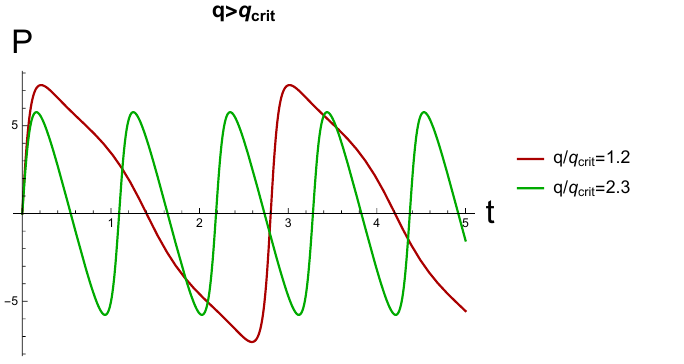
Figure 2 . The momentum time dependence for di(cid:11)erent charge values and (cid:22) = 1 : 3, d = 3, z h = 1, z (cid:3) = 0 : 1. The red line corresponds to the neutral particle, the green one to q=q crit = 0 : 8 and the blue one to q = q crit .